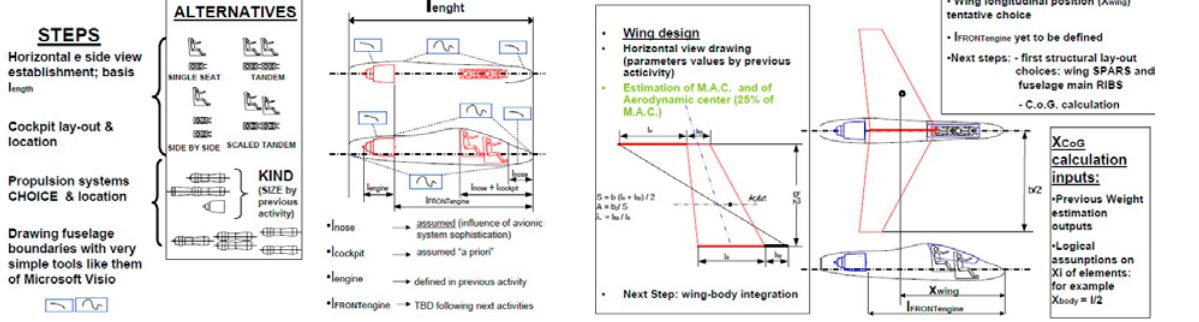
Fig. 10. Procedure’s steps and pre-defined figures Fig. 11. Wing platform and fuselage sketch (men,